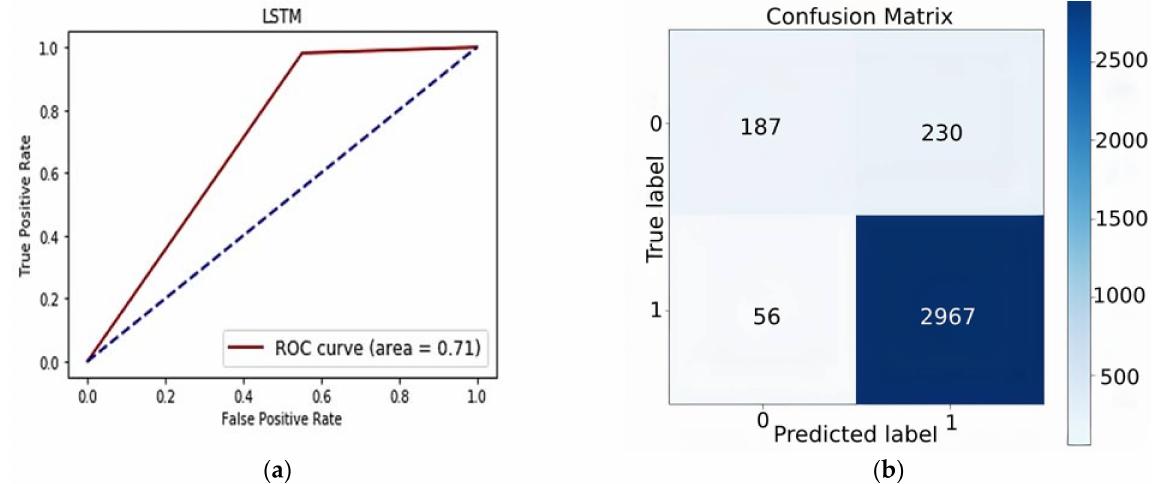
Figure 5. ( a ) AUROC curve of LSTM-based model and ( b ) the confusion matrix of the LSTM-based model.